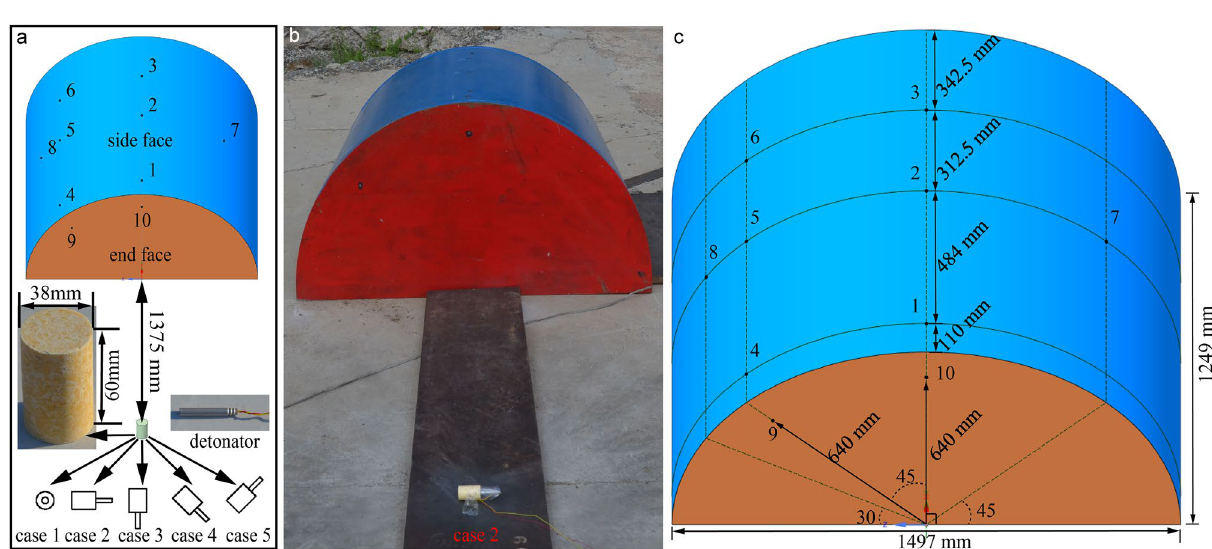
Figure 2. Test arrangement. ( a ) Location of charges, detonators and cylindrical shells. ( b ) Test 3 of Case 2. ( c ) Location of 10